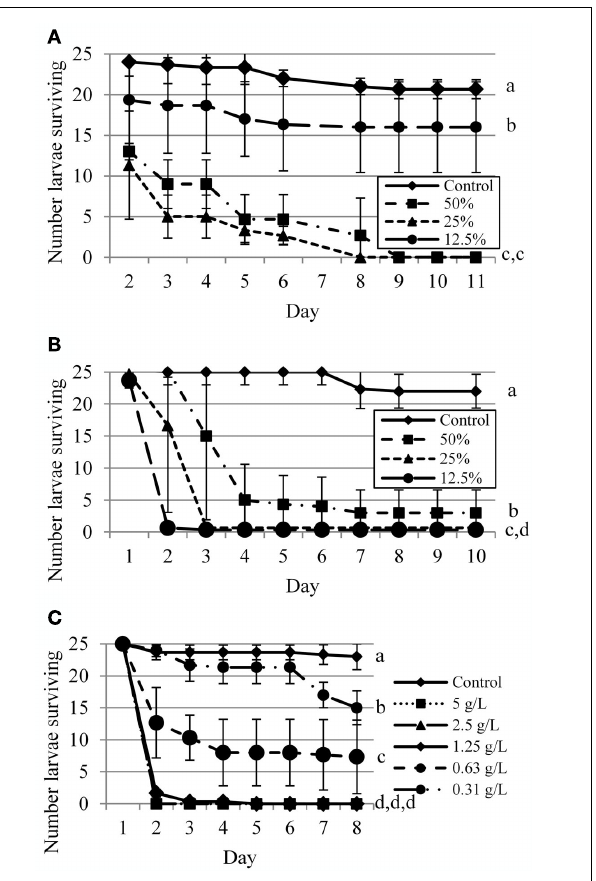
FIGURE 2 | Survival curves for Aedes albopictus larvae exposed to varying concentrations of regular coffee (A), decaffeinated coffee (B), or caffeine (C). Curves followed by different letters are significantly different ( p < 0.05) byWilcoxon analysis of Kaplan–Meier survival